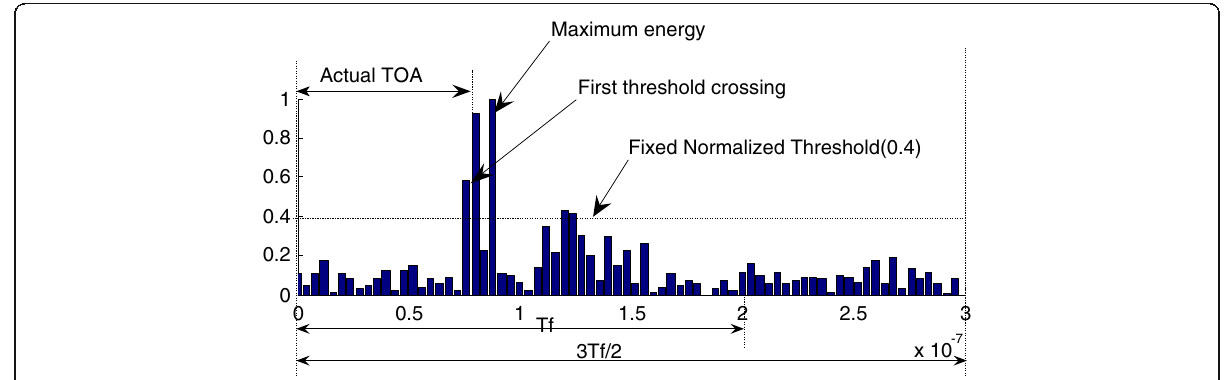
Fig. 2 TOA estimation techniques based on received